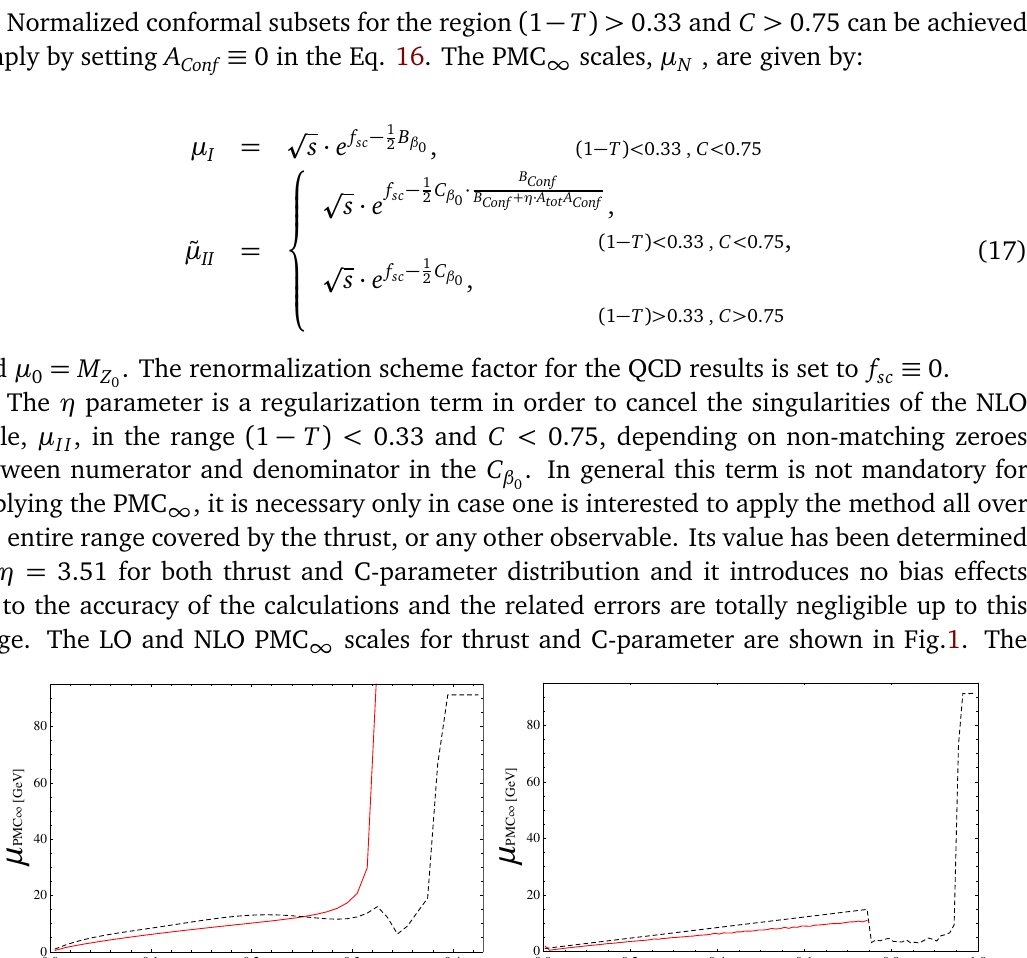
(cid:112) s and of the event shape